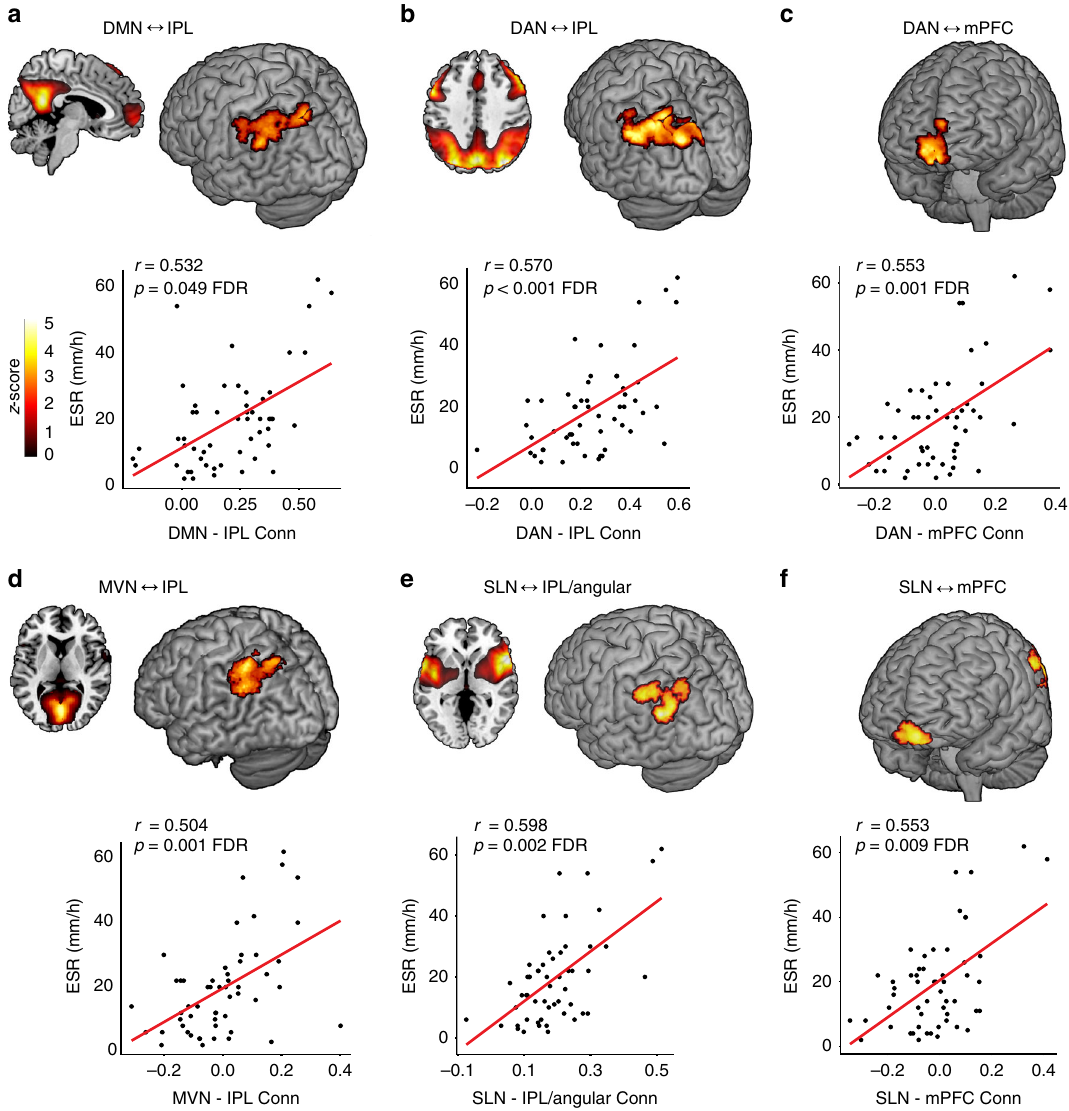
Fig. 2 In fl ammation-associated functional connectivity patterns. Brain regions (medial prefrontal cortex [mPFC], inferior parietal lobule [IPL]) showing positive connections to the default mode network (DMN; a ), dorsal attention network (DAN; b , c ), medial visual network (MVN; d ), and salience network (SLN; e , f ) at higher levels of peripheral in fl ammation. Scatterplots showing the strength connectivity and levels of erythrocyte sedimentation rate (ESR) are displayed below brain images. All associations were detected using seed networks identi fi ed by independent component analysis in a whole-brain search with ESR as the primary predictor of interest controlling for age and sex with p < 0.05 false discovery rate (FDR) cluster corrected for multiple − 0.28; both p < 0.05; Pearson correlation). All of the tested associations are displayed in Table 5.